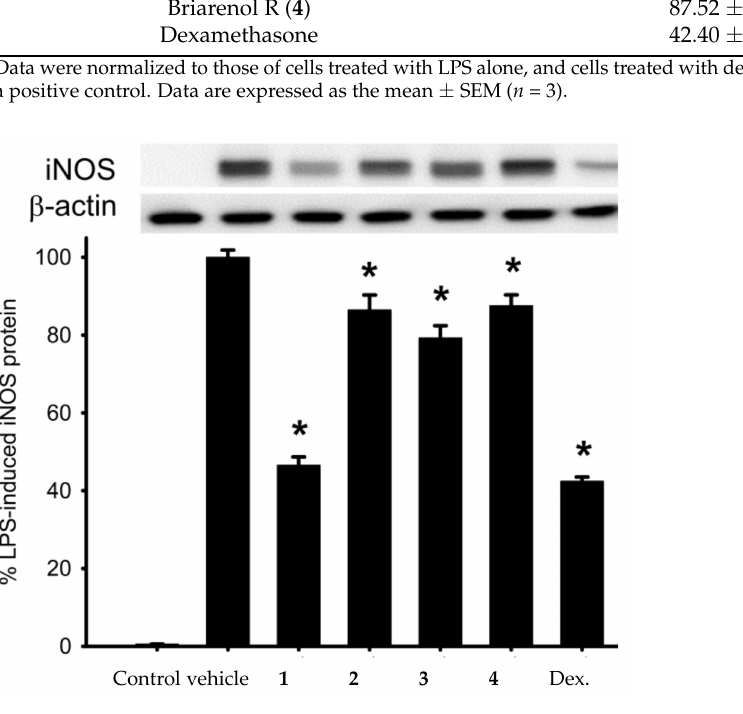
Figure 4. Western blotting showed that briaexcavatolide P ( 1 ) reduced the expression of iNOS. Data were normalized to the cells treated with LPS only, and cells treated dexamethasone (Dex.) were used as positive control. Data are expressed as the mean ± SEM ( n = 3). * Significantly different from cells treated with LPS ( p <